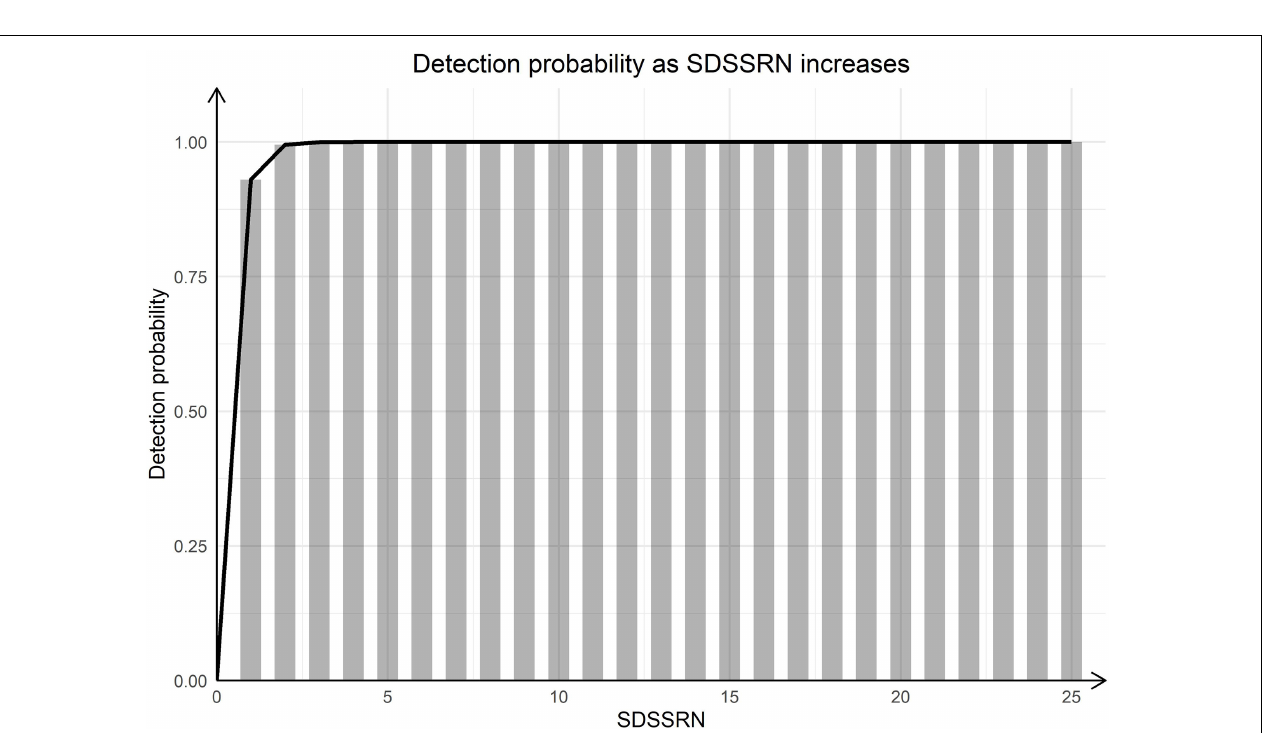
FIGURE 3 | Detection probability with increasing SDSSRN. Bars were calculated as (1–0.15 SDSSRN ).